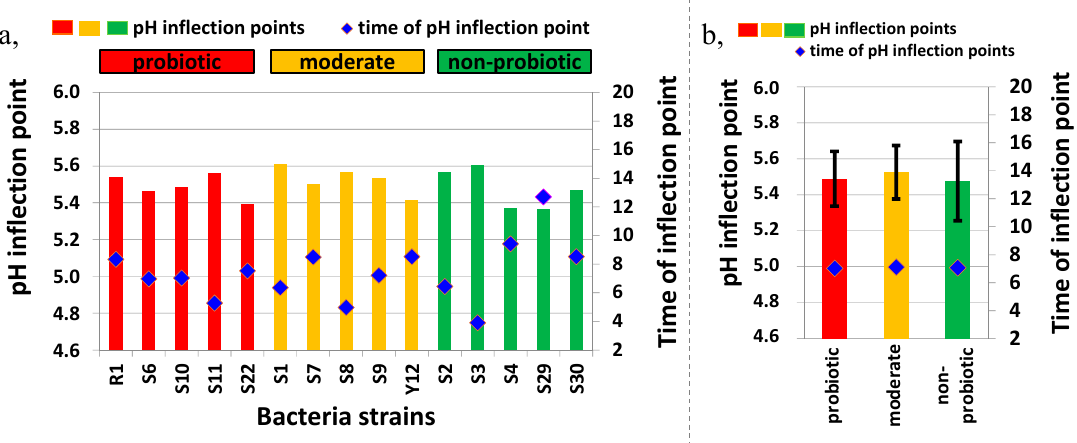
Figure 2. ( a ), Inflection points and time of the inflection points of the pH curves of the tested Lactobacillus strains ( n = 15) and ( b ), an average of the inflection points and time of the inflection points of the pH curves of the non-probiotic, moderately probiotic, and probiotic groups measured during milk fermentation ( n = 15).